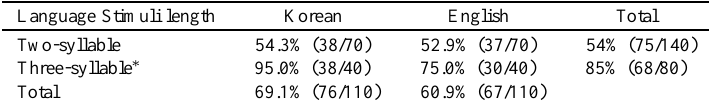
Table 1 Error rates (%) (Number of stimuli with errors/Total number of stimuli) in Korean and English writings depending on stimuli length